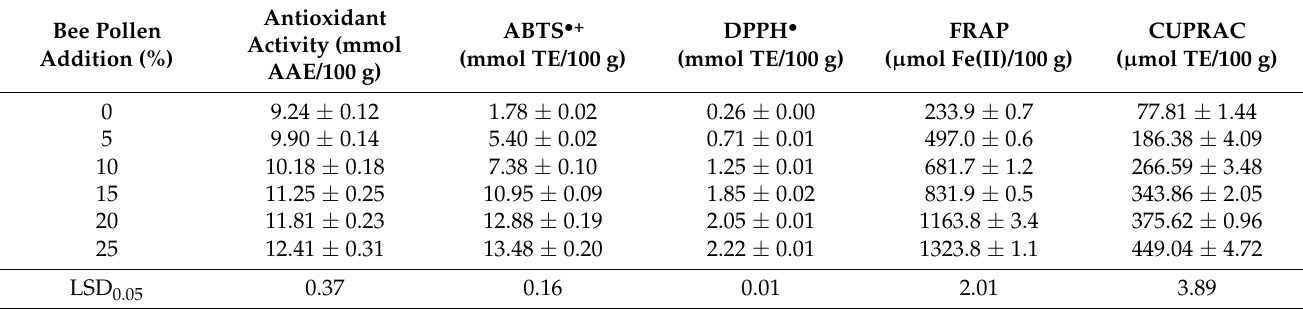
Table 3. The antioxidant, antiradical, and reducing activities of multiflower honey and honey samples enriched with bee